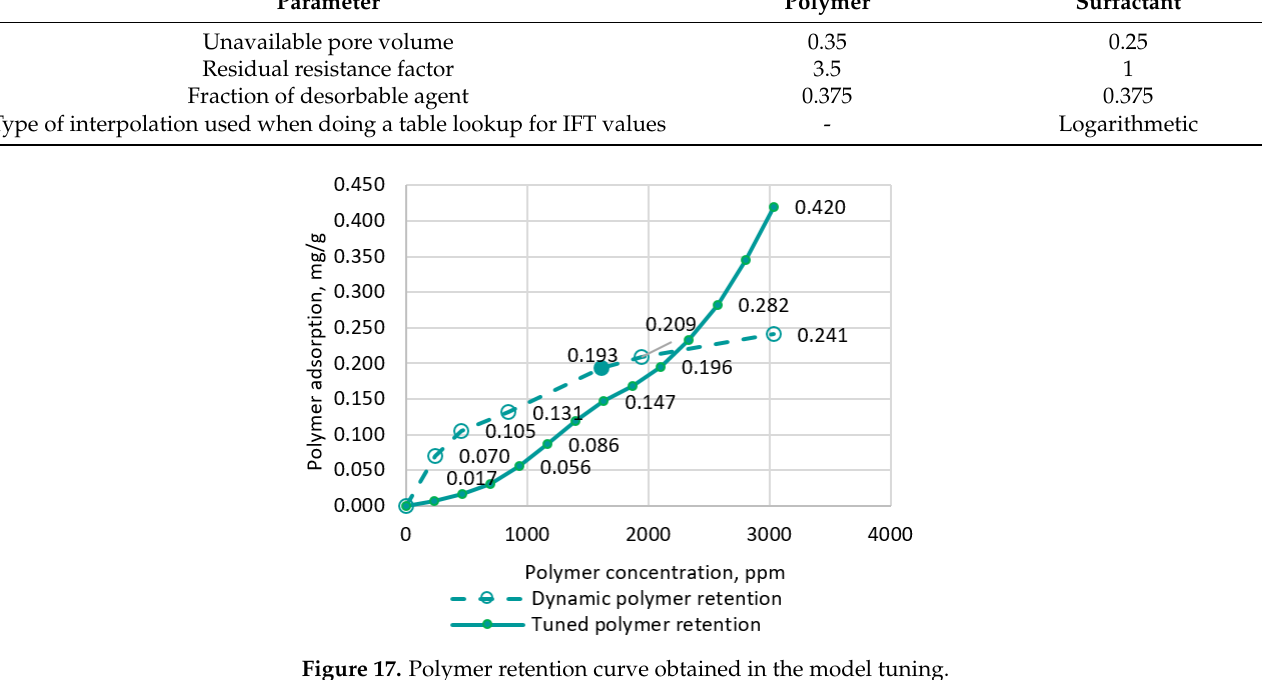
Figure 18. Surfactant retention curve obtained in the model tuning.